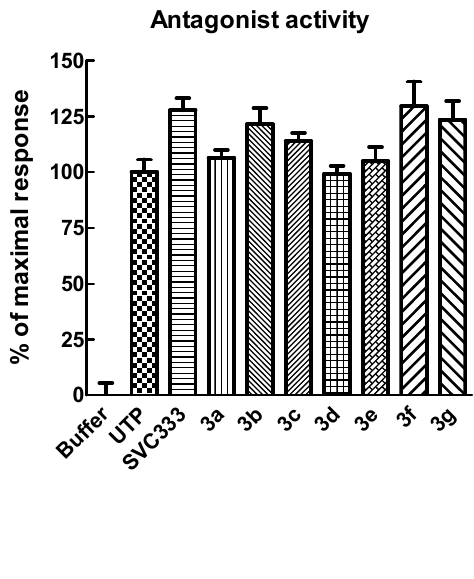
Figure 3. Effect of high concentrations of phosphonate analogues 3a – g on the P2Y receptor-mediated activity of UTP. The effects of 30 μ M concentrations of the indicated phosphonates were tested in the presence of 100 μ M UTP in 1321N1-P2Y